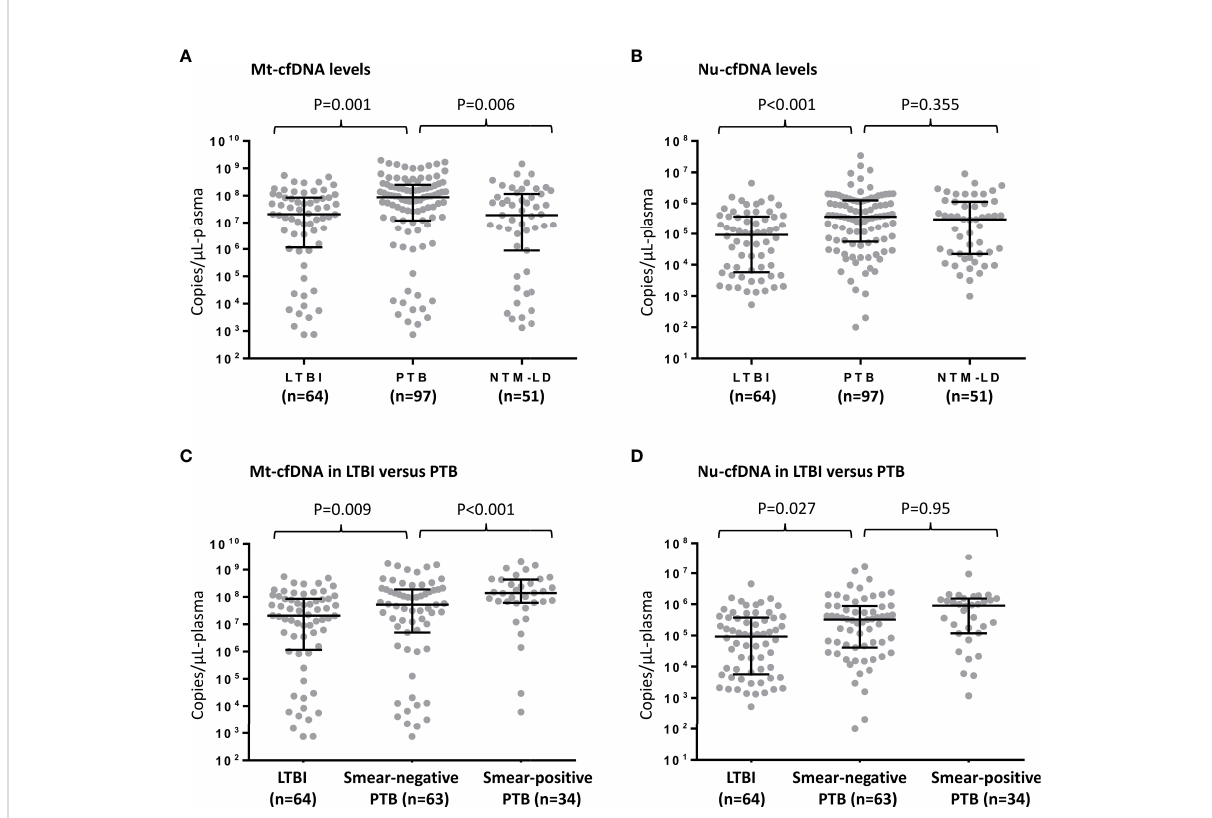
FIGURE 2 Human mitochondrial cell-free DNA (Mt-cfDNA) (A) and nuclear cell-free DNA (Nu-cfDNA) (B) levels in persons with latent tuberculosis infection (LTBI), pulmonary tuberculosis (PTB) and nontuberculous mycobacterial lung disease (NTM-LD). The levels of Mt-cfDNA (C) and Nu- cfDNA (D) in LTBI, smear-negative PTB (n=63, including 24 pathology-con fi rmed and 39 culture-positive cases) and smear-positive PTB subgroups. Data are presented as medians with interquartile ranges, and with each dot representing a